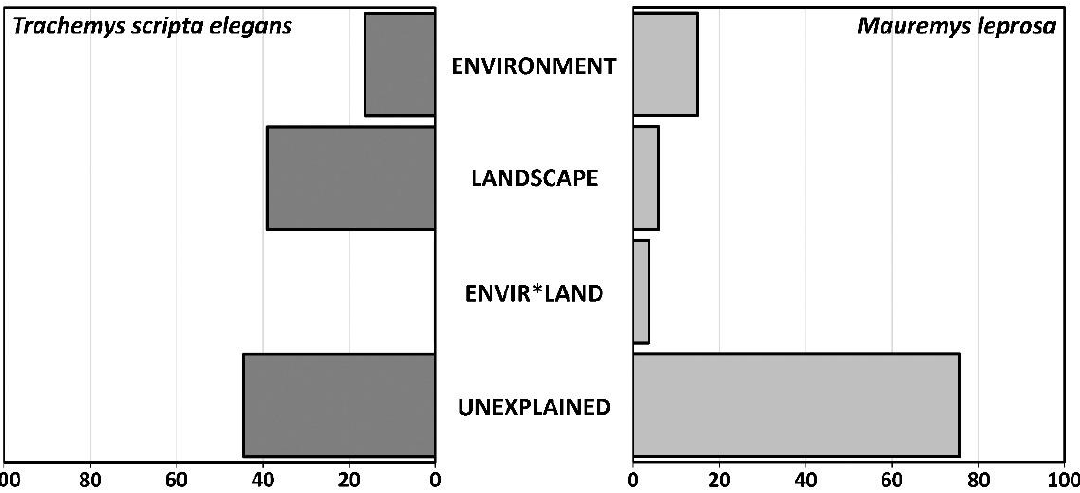
Figure 3. Percentage of variance in the distribution of each species explained by the two sets of explanatory variables (i.e., environmental and landscape variables) according to variance partitioning analysis.